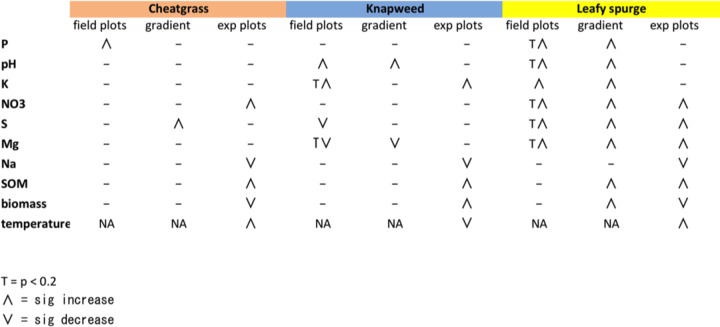
Changes in soil physicochemical variables relative to native plant communities across the invasion gradients, field plots, and experimental (exp) plots. P values were calculated using paired t tests (native versus invaded; significance threshold of P < 0.05). The uptick symbols denote a significant increase relative to controls, while the downticks indicate a significant decrease.